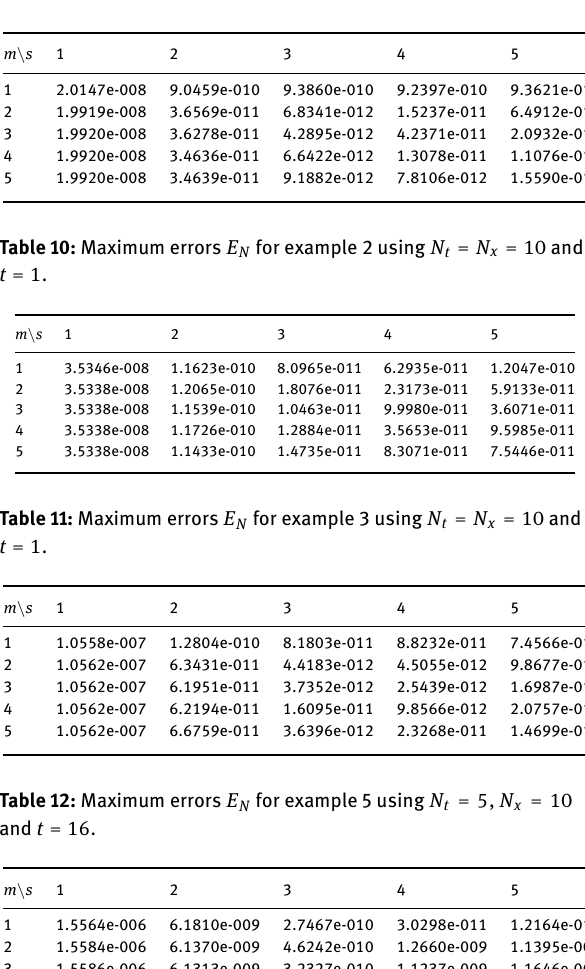
Table 9: Maximum errors E N for example 1 using N t = N x = 10 and t = 1.